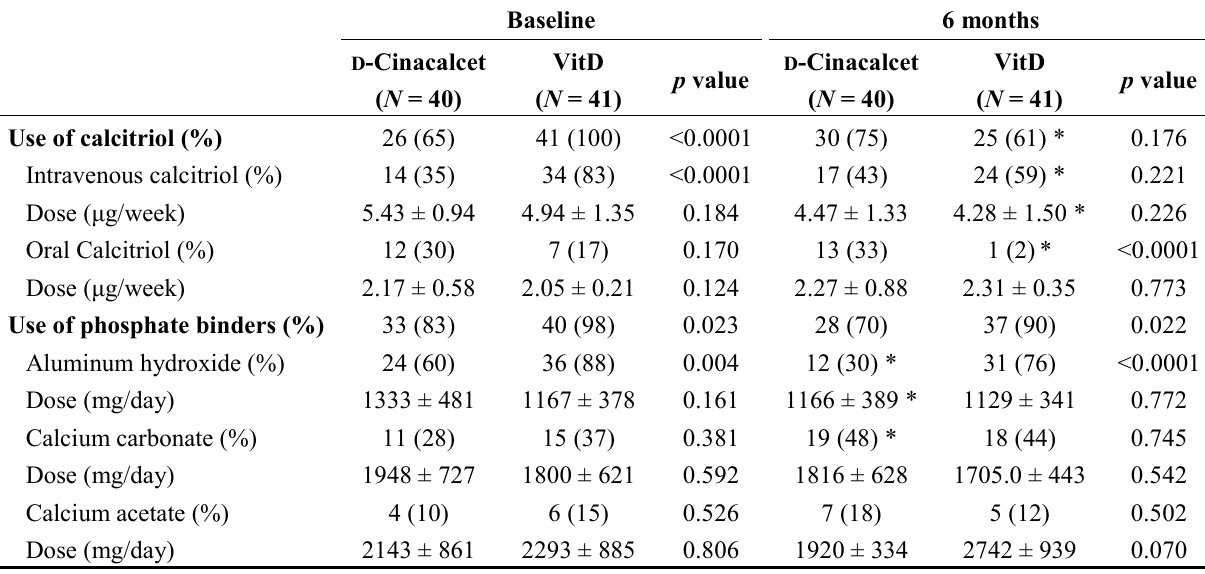
Table 3. Use and dosage of calcitriol and phosphate binders at baseline and after treatment of 6